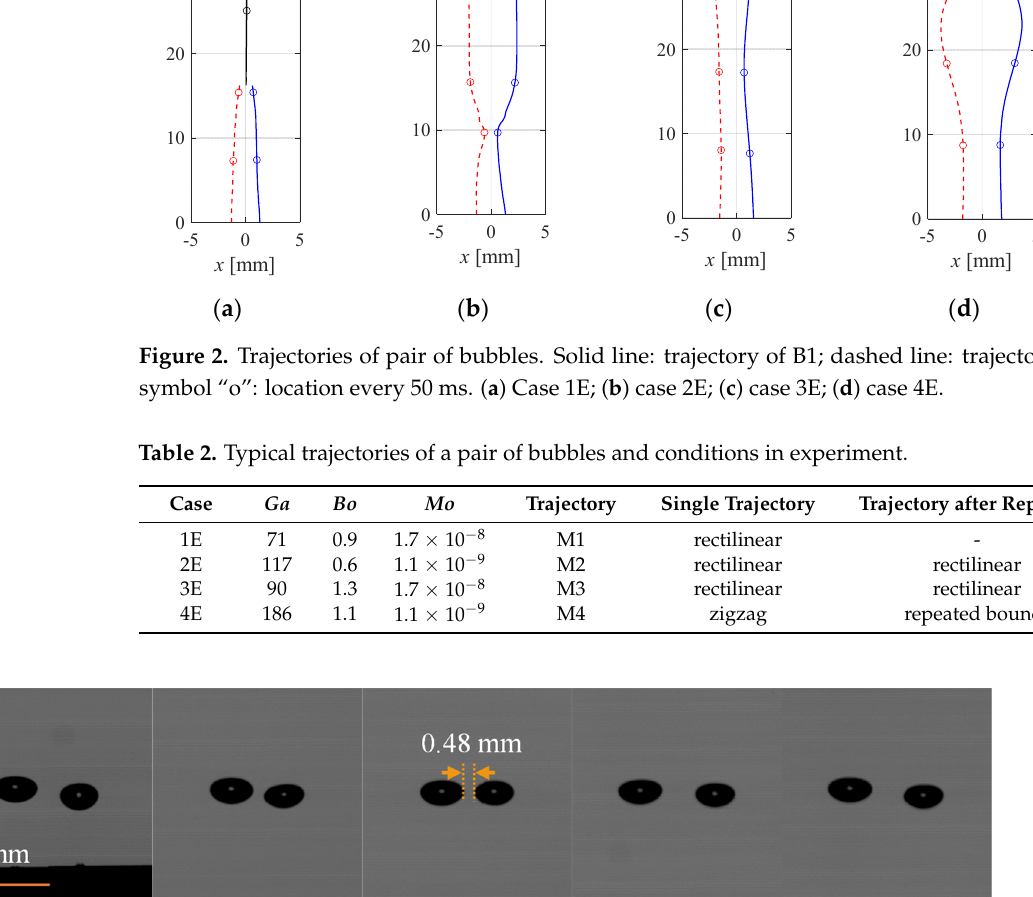
Figure 3. A nonkissing repulsive motion of a pair of bubbles in case 3E.